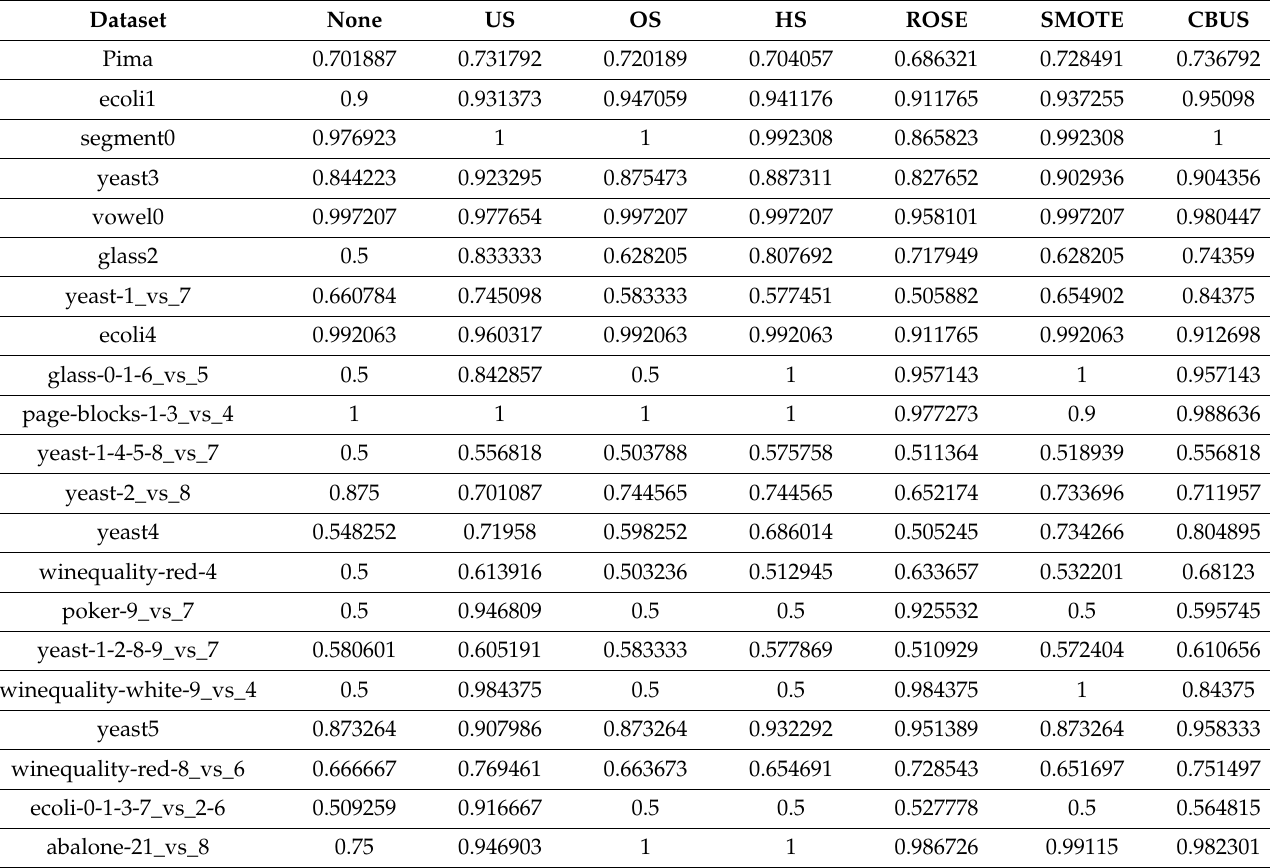
Table 6. Performance of DBT for